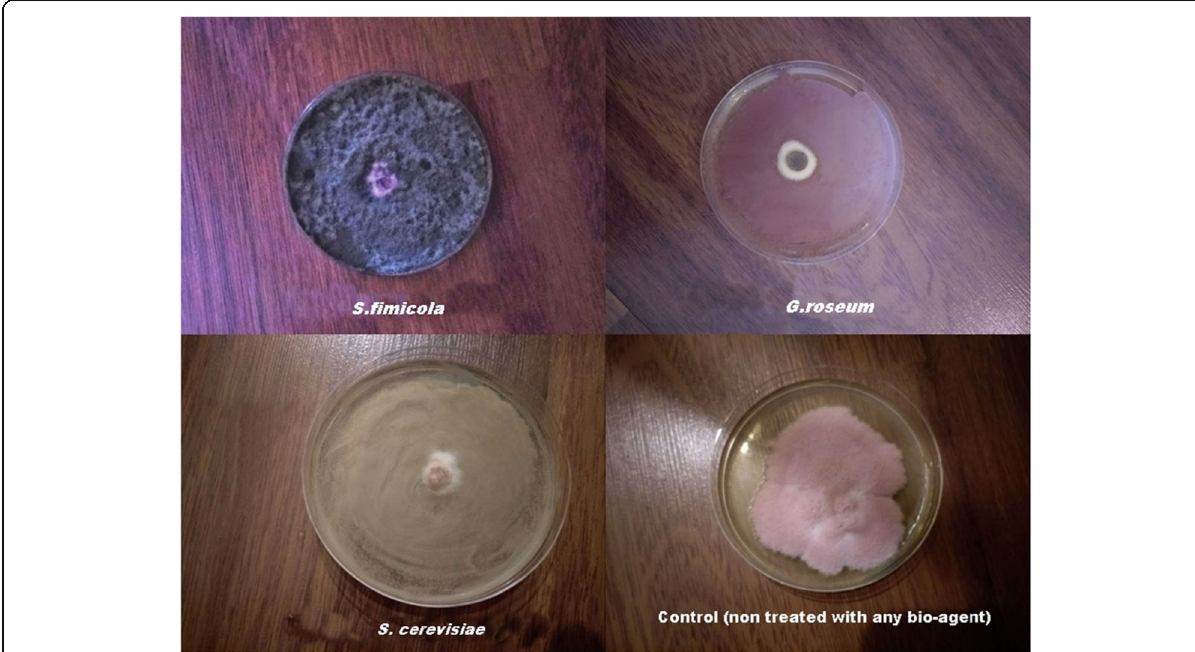
Fig. 1 The mycelial growth of F . graminearum after in vitro treatments with the bio-agents at 1 × 10 9 spores/ml and the control